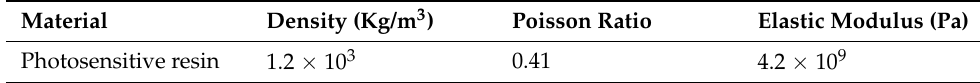
Table 2. Material properties of photosensitive resin.